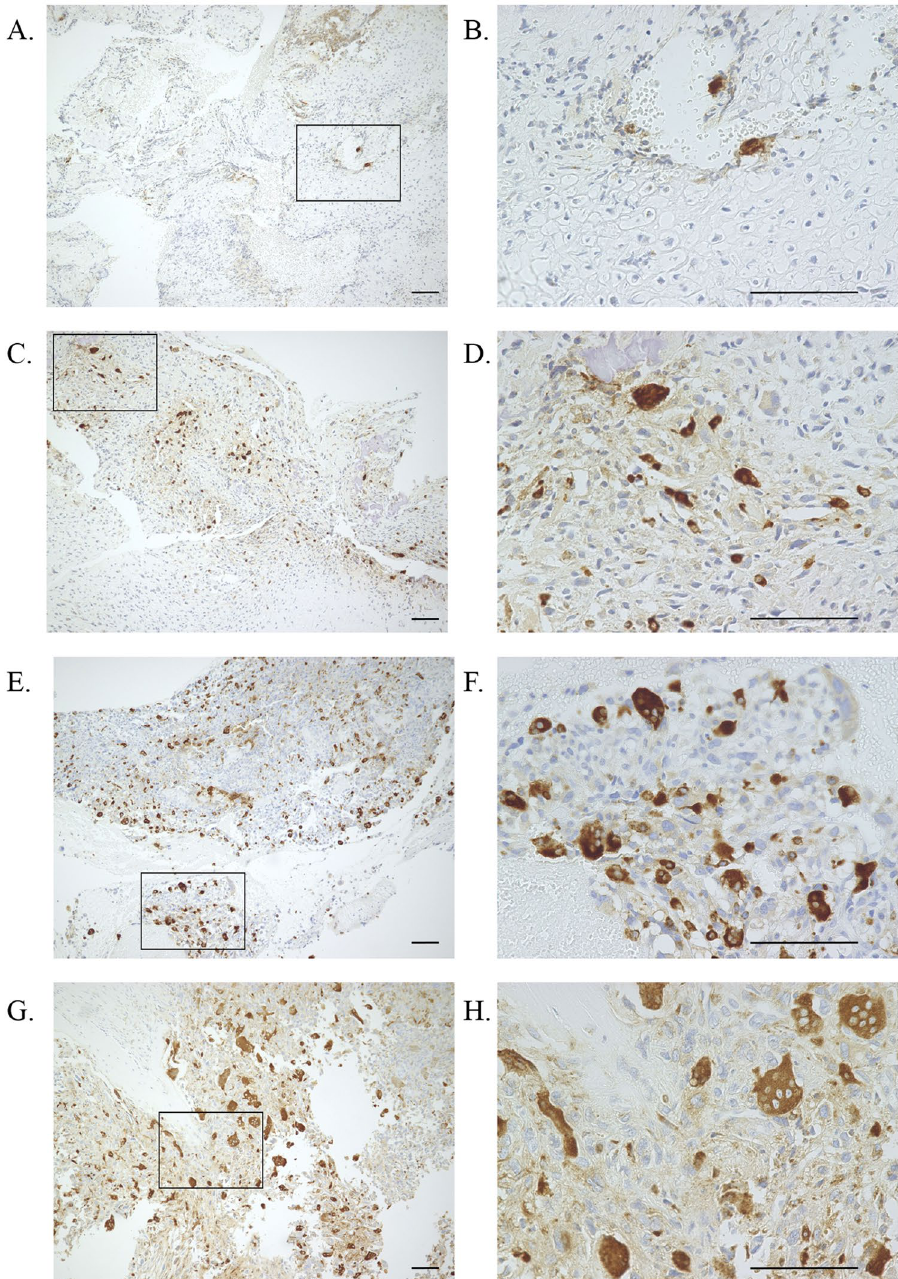
Figure 1. ( A ) Few Cathepsin K-positive cells were observed in a biopsy specimen (Magnification; × 10, Scale bar ; 100 µm). ( B ) Cathepsin K-positive cells with ≥ 3 nuclei were not observed in a marked area of ( A ) . (Magnification; × 40, Scale bar ; 100 µm). ( C ) Cathepsin K-positive cells were observed in a biopsy specimen (Magnification; × 10, Scale bar ; 100 µm). ( D ) The observevd number of Cathepsin K-positive cell with ≥ 3 nuclei was 1 in a marked area of ( C ) . (Magnification; × 40, Scale bar ; 100 µm). ( E ) Numerous Cathepsin K-positive cells were observed in a biopsy specimen (Magnification; × 10, Scale bar ; 100 µm). ( F ) The observed number of Cathepsin K-positive cell with ≥ 3 nuclei were 8 in a marked area of ( E ). (Magnification; × 40, Scale bar ; 100 µm). ( G ) Numerous Cathepsin K-positive cells were observed in a biopsy specimen (Magnification; × 10, Scale bar ; 100 µm). ( H ) The observed number of Cathepsin K-positive cell with ≥ 3 nuclei were 10 in a marked area of ( H ). (Magnification; × 40, Scale bar ; 100